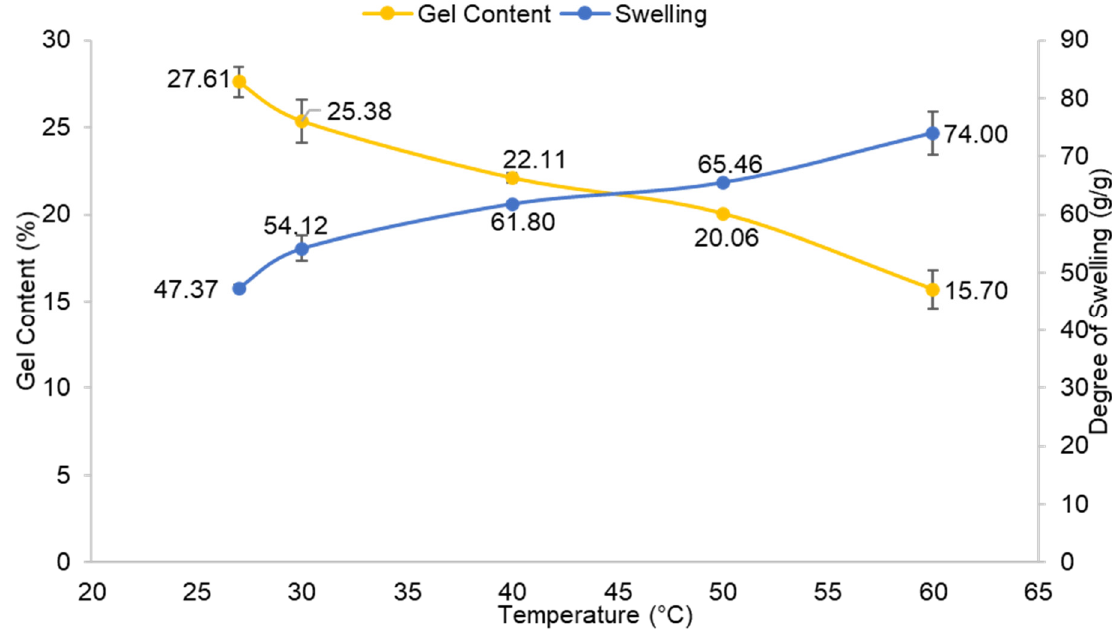
Figure 7. Effect of reaction temperature on gel content and degree of swelling of CMC hydrogel. Error bar indicates the standard deviation of uncertainty.